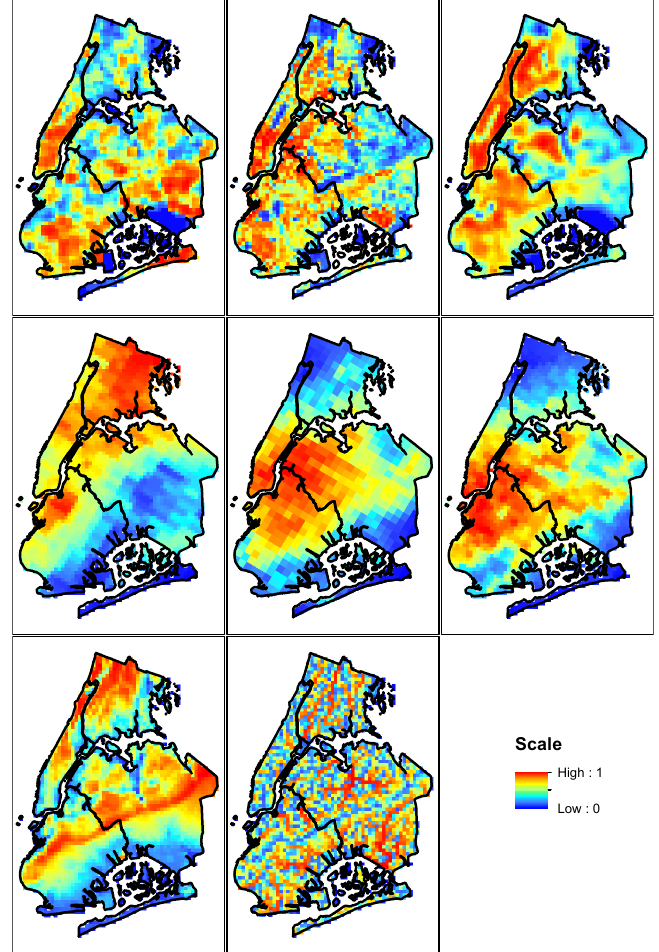
Figure 8. Normalized (0 to 1) maps for flooding ( top left ), impervious surface percentage ( top center ), population density ( top right ), daily-averaged rain for entire study period ( center left ), daily-averaged rain for the 50 rainiest days ( center center ), daily-averaged rainfall from days with top 50 one-hour rainfall ( center right ), absolute elevation ( bottom left ), and flow accumulation ( bottom center ). Color bar represents all